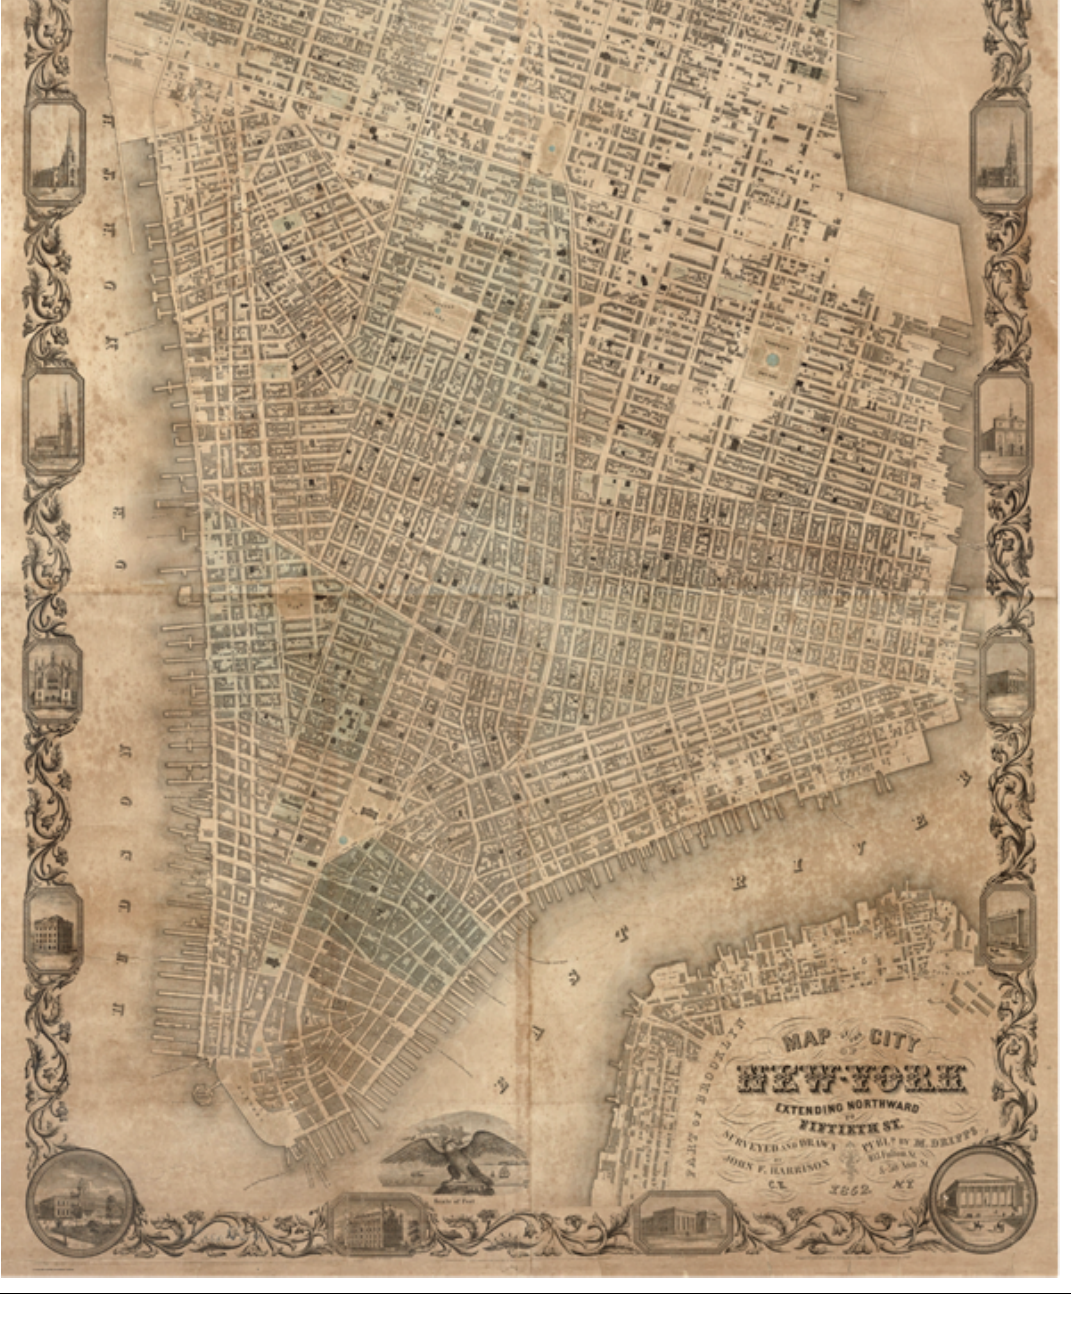
Figure 3. Partial view of the ‘Map of the City of New York Extending Northward to Fiftieth’ (Source: David Rumsey Map